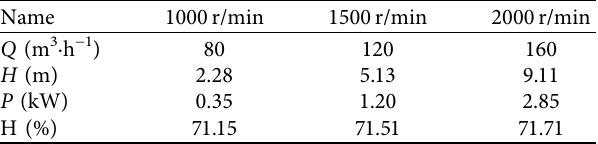
Table 2: BEP parameters by CFD at different rotational speeds.